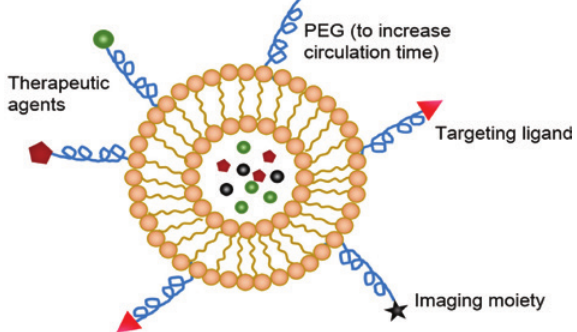
Figure 3: Schematic of liposomes used in cancer therapy. Liposomes are composed of lipids with PEG to increase their cir- culation time. They can be functionalized with therapeutic agents, targeting ligands, and imaging moieties or contrast